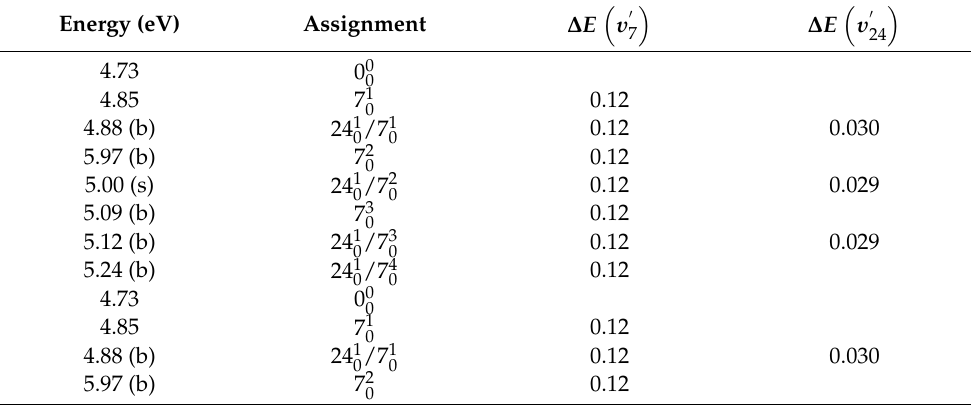
Table 3. Proposed vibrational assignments in the 4.6 − 5.4 eV absorption band of 2BrPyr (Band II). ∆ E (in eV) represents the energy of one extra quanta in the vibrational progression. The symbol “/” means both modes are involved.